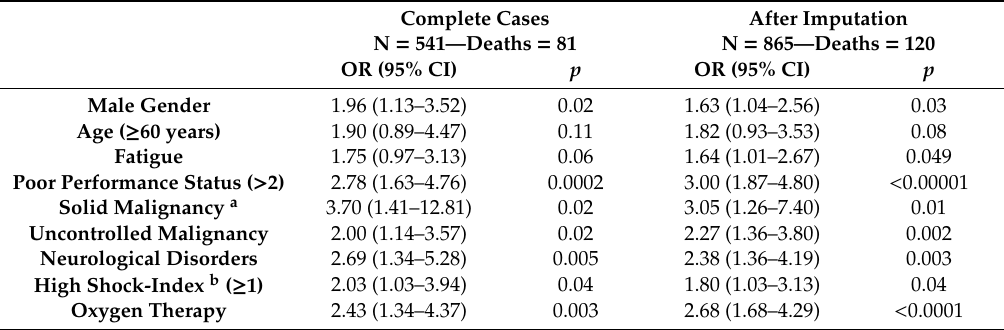
Figure 4. Effects on the 30-day mortality of covariates identified by multivariate logistic regression after imputation of the missing data. * Reference: hematological malignancy. Table 5. Multivariable analysis. Variables independently associated with a 30-day mortality for patients hospitalized after visiting the ED ( N = 896) before and after the imputation of missing data, except for the outcome that was not imputed (355 patients had at least one missing data, among which 31 concerned the outcome).